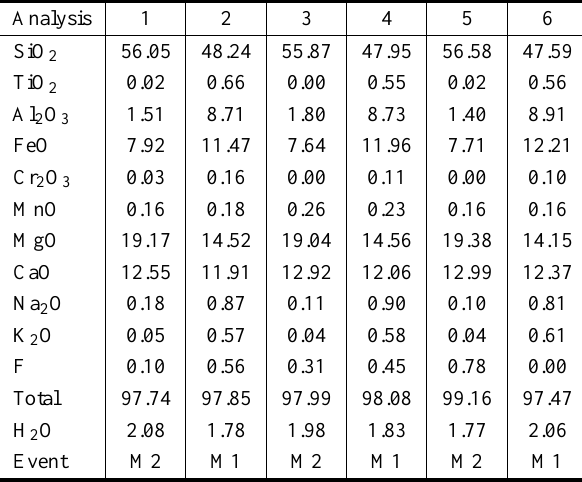
Selected electron microprobe chemical analyses of amphi- boles from the dated ultramafic amphibolite sample. Total number of analyses = 26; 0.00 = below detection